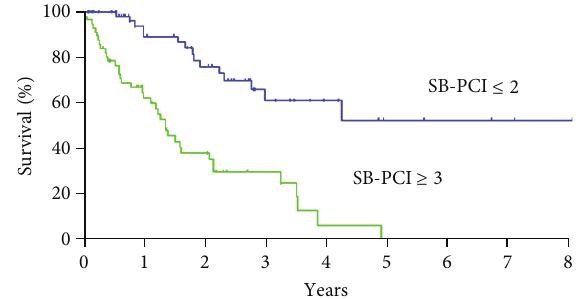
Figure 5: Survival curves of patients with small bowel PCI (SB- PCI) ≤ 2 and those with SB-PCI ≥ 3. MST and 5-year survival rate in patients with SB-PCI ≤ 2 were NR and 52%, but those in patients with SB-PCI ≥ 3 were 10.1 months and 0 %,